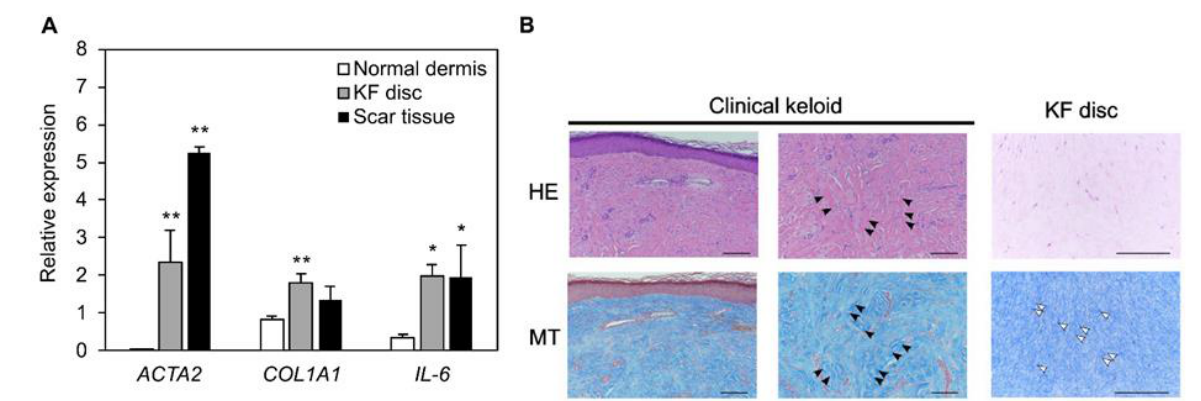
Figure 3. Comparison between collagen discs and scars in histology and gene expression. ( A ) qPCR analysis of scar markers in normal tissue, KF discs and scar tissue from patients. Results are presented as the mean ± standard deviation of three biological replicates. * p < 0.05, ** p < 0.01, compared with normal dermis gene expression, one way analysis of variance followed by Tukey’s multiple method. ( B ) Representative images of hematoxylin and eosin-stained and Masson’s Trichrome- stained clinical keloid tissue and KF disc sections are shown. Black arrows indicate the thick collagen fiber bundles in the deep dermis of keloid. White arrows indicate partial bundles of collagen discs. All bars indicate 200 µ m. Abbreviations: qPCR, quantitative real-time polymerase chain reaction; KF, keloid fibroblasts.